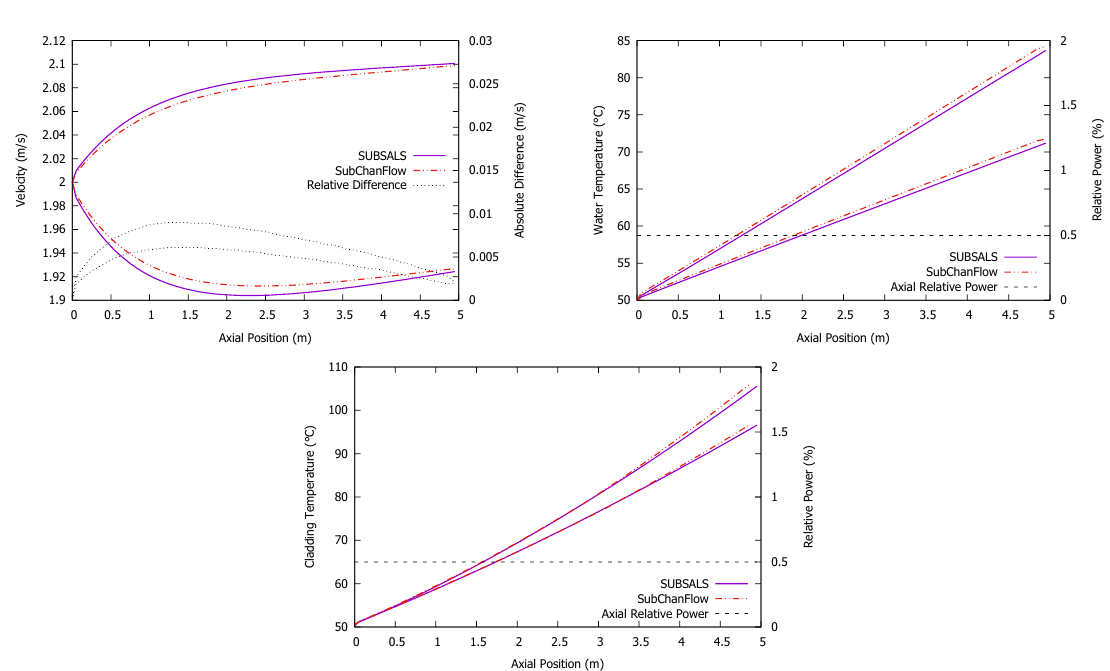
Figure 6. Comparison of axial velocity (top left), water temperature (top right) and cladding temperature (bottom) distribution calculations with uniform axial power distribution.